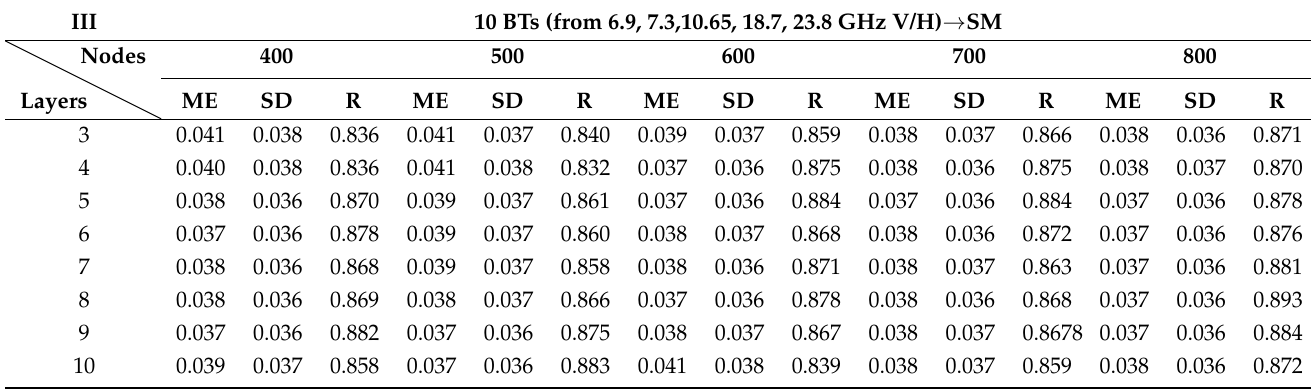
Table 3. Ten channels are used to retrieve SM (brightness temperature combination of ten channels).